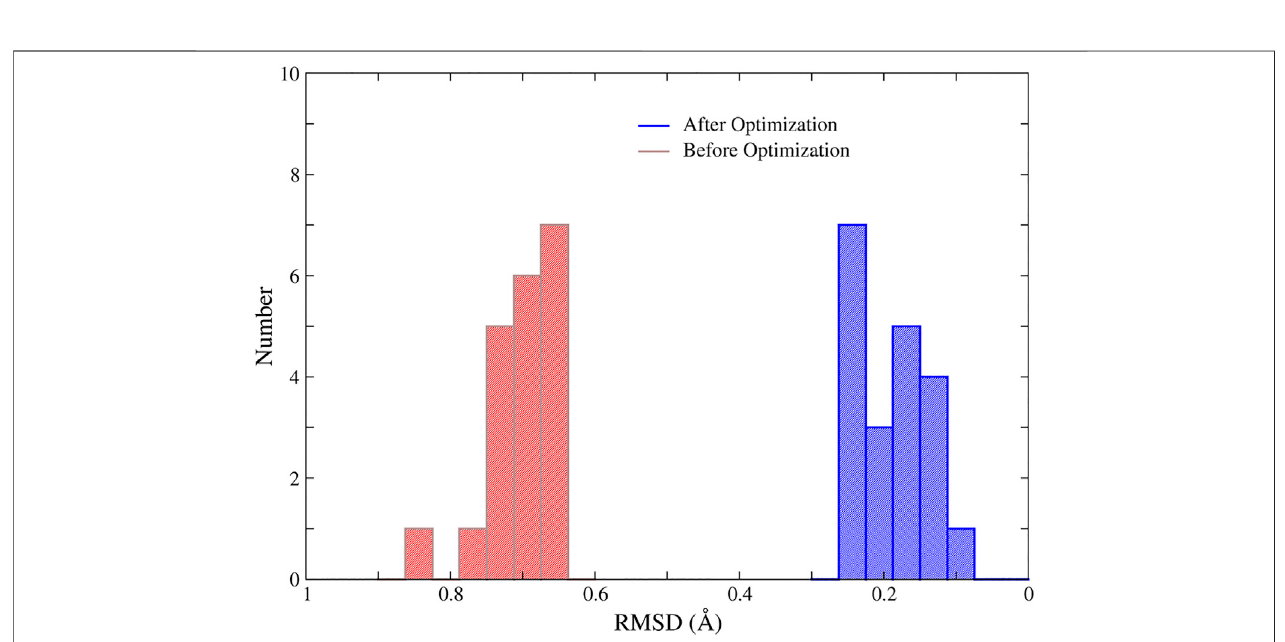
FIGURE 7 | The RMSD of the MBGs in ill and optimized structures of the 1ZIN protein. The MBG of the X-ray structure was taken as the reference.